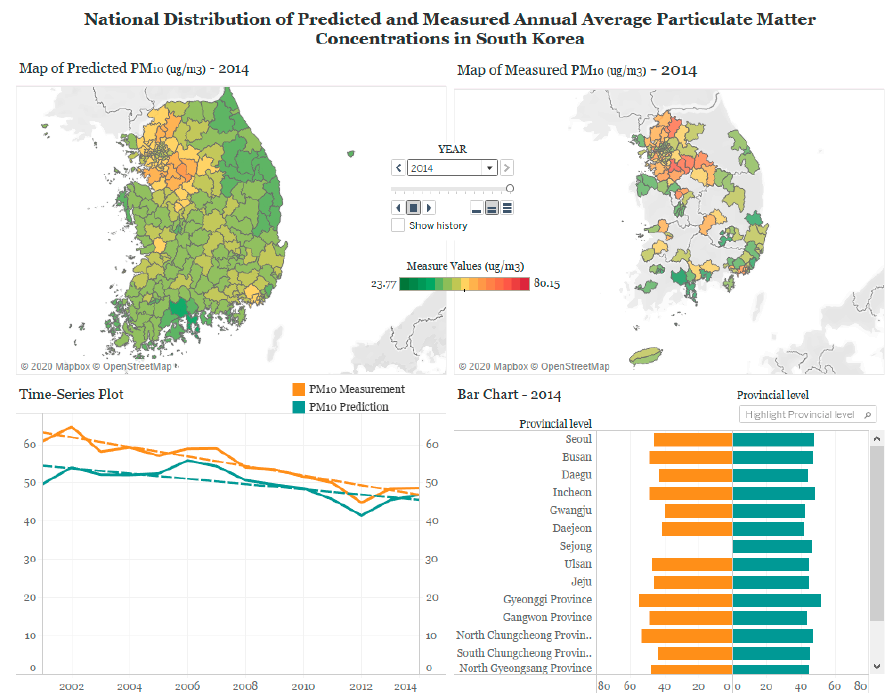
Figure 2. An example of the Tableau dashboard for visualizing measured and predicted annual average particulate matter with an aerodynamic diameter ≤ 10 μ m (PM 10 ) concentrations (µg/m 3 ) in South Korea, 2001–2014 (maps presented above show the concentrations for the year 2014 selected on the ‘pages shelf’ and can be replaced with concentrations in any specific year when selected).